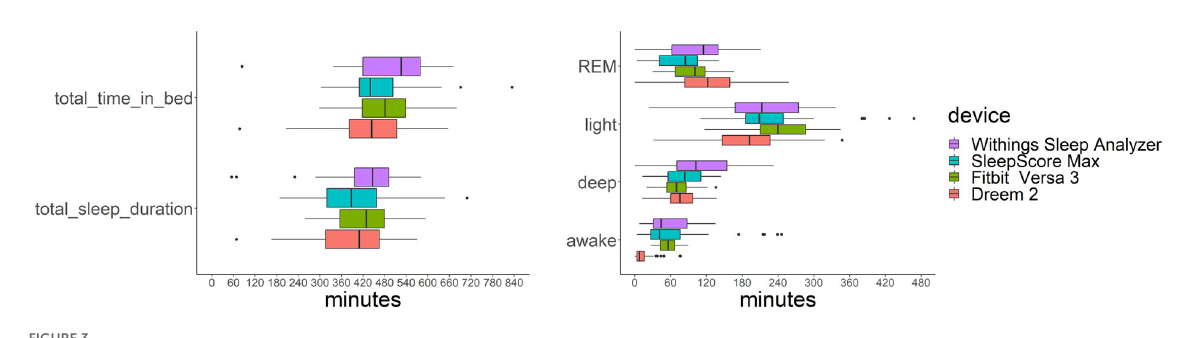
FIGURE3 Distribution of sleep data from each of the four